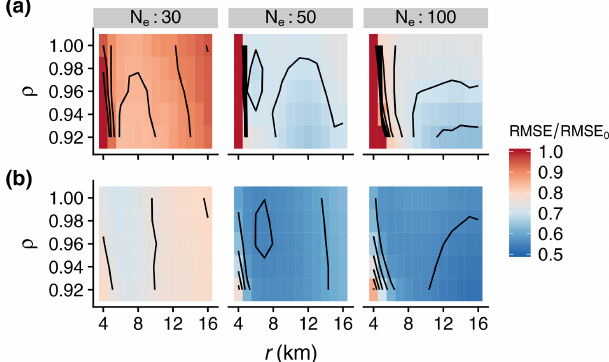
Figure 7. RMSE at t = 20a, relative to the initial (before assimila- tion) RMSE as a function of the forgetting factor ρ and the locali- sation radius r for different ensemble sizes N e . (a) For the bed and (b) for the friction coefficient. Black lines show isovalues spaced by